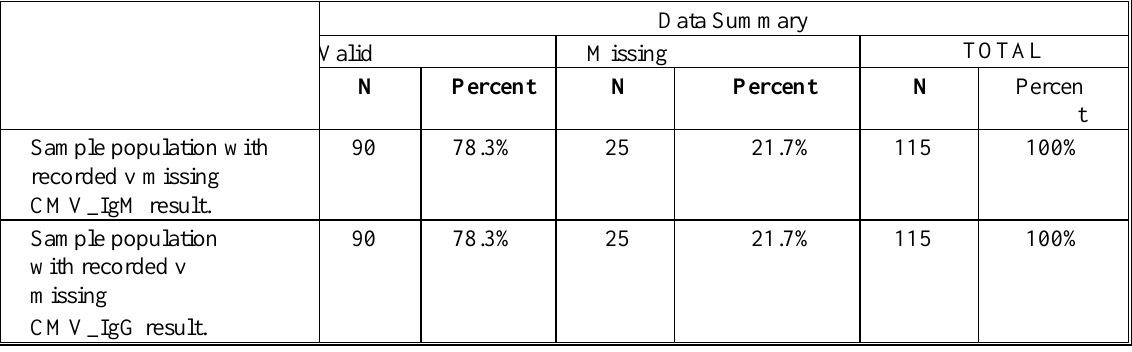
Table 1. Sample population with recorded versus missing IgG and IgM results